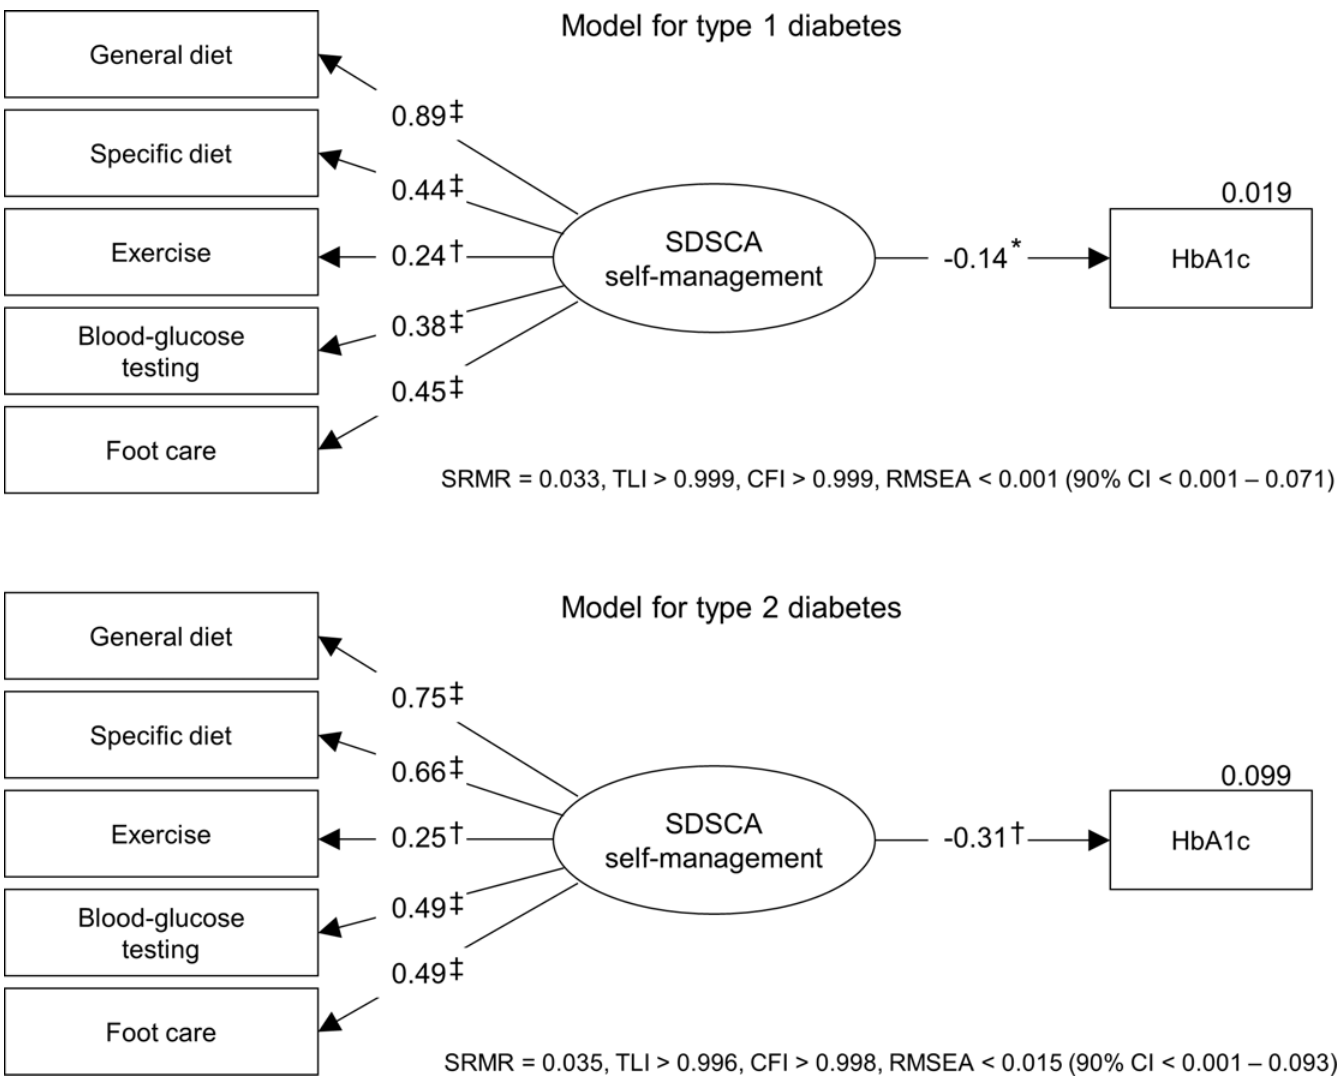
Fig 2. Stuctural equation model of diabetes self-management as measured by the SDSCA and glycaemic control for patients with type 1 and type 2 diabetes. Data are standardised regression weights ( β ) for paths or squared multiple correlations ( R 2 ) for variables. Boxes indicate manifest measurement variables; ovals indicate latent variables operationalised by manifest indicators; error terms are not displayed for ease of presentation. SRMR, Standardised Root Mean Square Residual; TLI, Tucker Lewis Index; CFI, Comparative Fit Index; RMSEA, Root Mean Square Error of Approximation. Indication of two- sided significance: * P < 0.05; † P < 0.01; ‡ P <